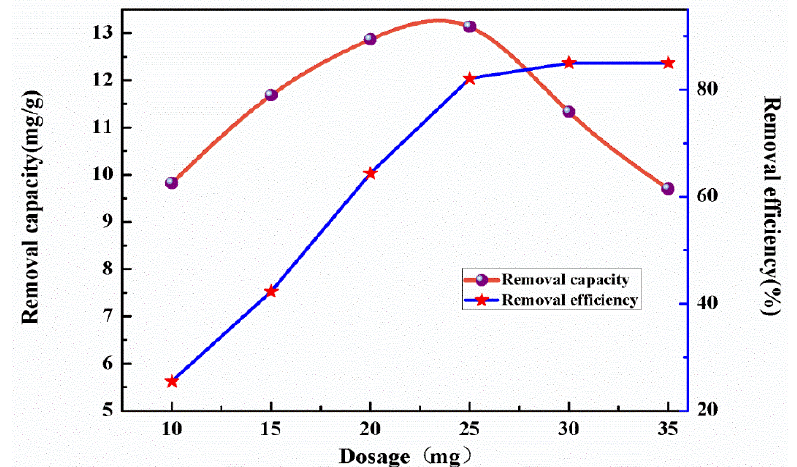
Figure 8. Effect of dosage on As(V) adsorption. Table 3. Constants of Langmuir and Freundlich isotherms.